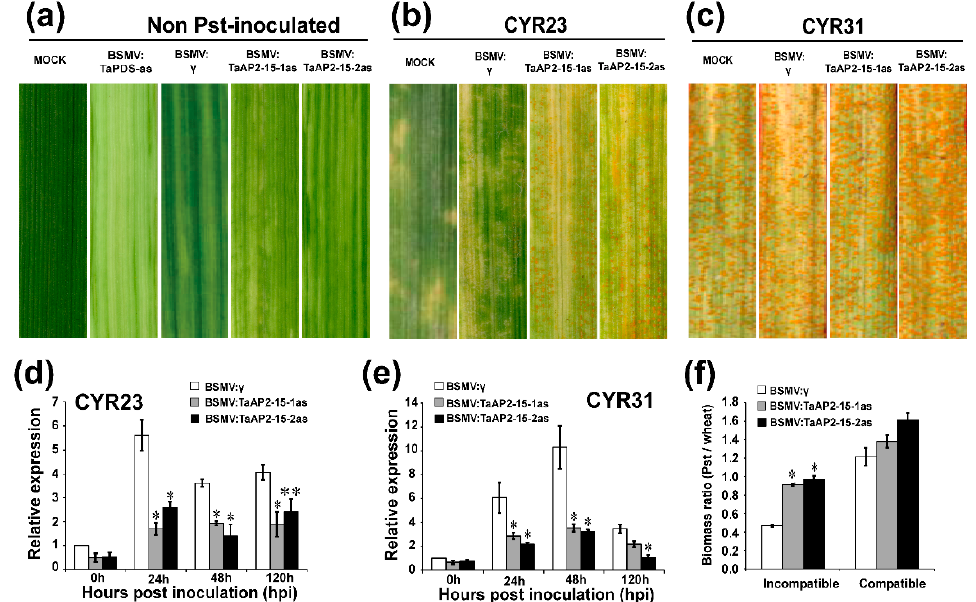
Figure 4. Silencing of TaAP2-15 enhances wheat susceptibility to Pst . ( a ) Mild chlorotic mosaic virus symptoms on virus-inoculated plants. Mock: 1 x Fes buffer-treated leaves. ( b,c ) The reaction (infection type) of plants challenged with CYR23 ( b ) or CYR31( c ) photographed 14 dpi. ( d,e ) Transcripts of TaAP2-15 in silenced or control plants (plants inoculated with BSMV: γ ) challenged with the avirulent CYR23 ( d ) and the virulent CYR31 ( e ). Relative quantity of the expression of TaAP2-15 was computed by the comparative threshold (2 − ∆∆ C t ) method. The transcript levels of this gene were quantified by qRT-PCR. The data were normalized with the transcripts of the reference gene, TaEF-1 α and are expressed as fold changes relative to the control (BSMV: γ ) at 0 h. Data obtained from control plants (BSMV: γ ) after Pst inoculation at 0 h were normalized as 1. ( f ) Fungal and wheat biomass ratio quantified from total genomic DNA content at 14 dpi. PstEF and TaEF-1 α were used as internal references. Significant differences between TaAP2-15 - knockdown and control plants computed using Student’s t -test are indicated by asterisks. *, p < 0.05, **, p < 0.01. All data were obtained from three biological replicas.